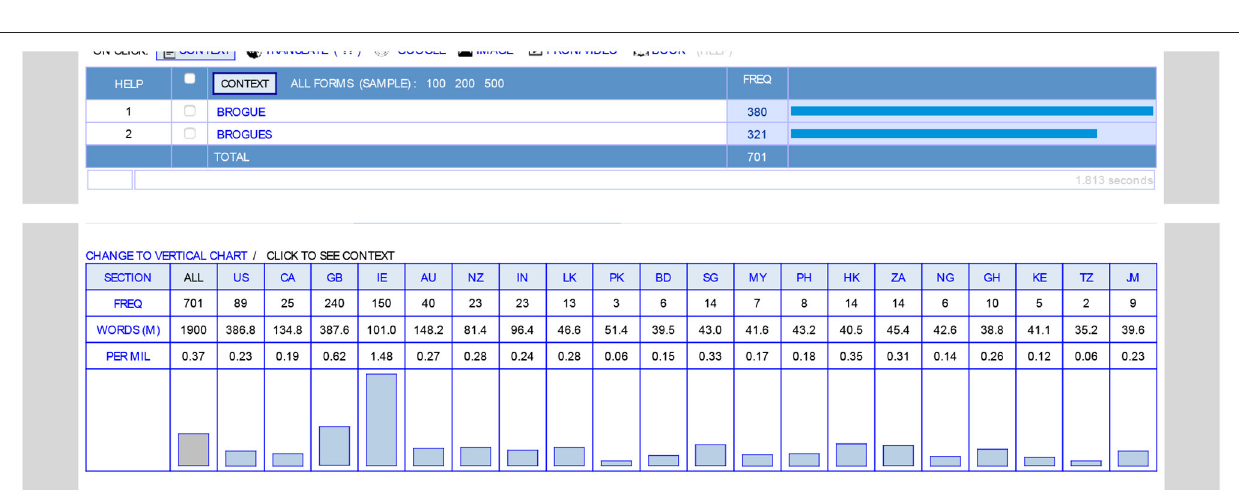
FIGURE 11 | Distribution of galore in the GloWbE Corpus (from https://www.english-corpora.org/glowbe/).